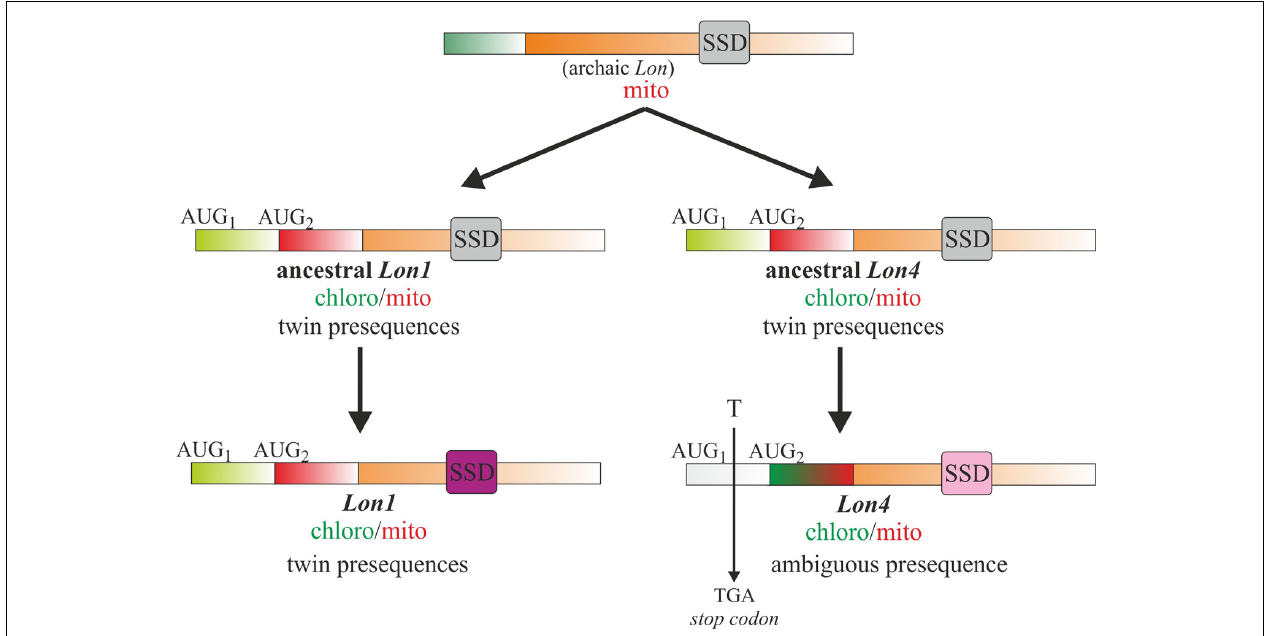
present-day Lon1 and Lon4 genes with discrete targeting mechanisms and SSD domains. A single base insertion between the two AUGs of the ancestral Lon4 was the impetus to evolve an ambiguous presequence for dual-organellar targeting.The variation of the SSD domain between Lon1 and Lon4 is associated with complementing sets of subfunctions allowing, through adaptive evolution, the maintenance of both functional paralogs.